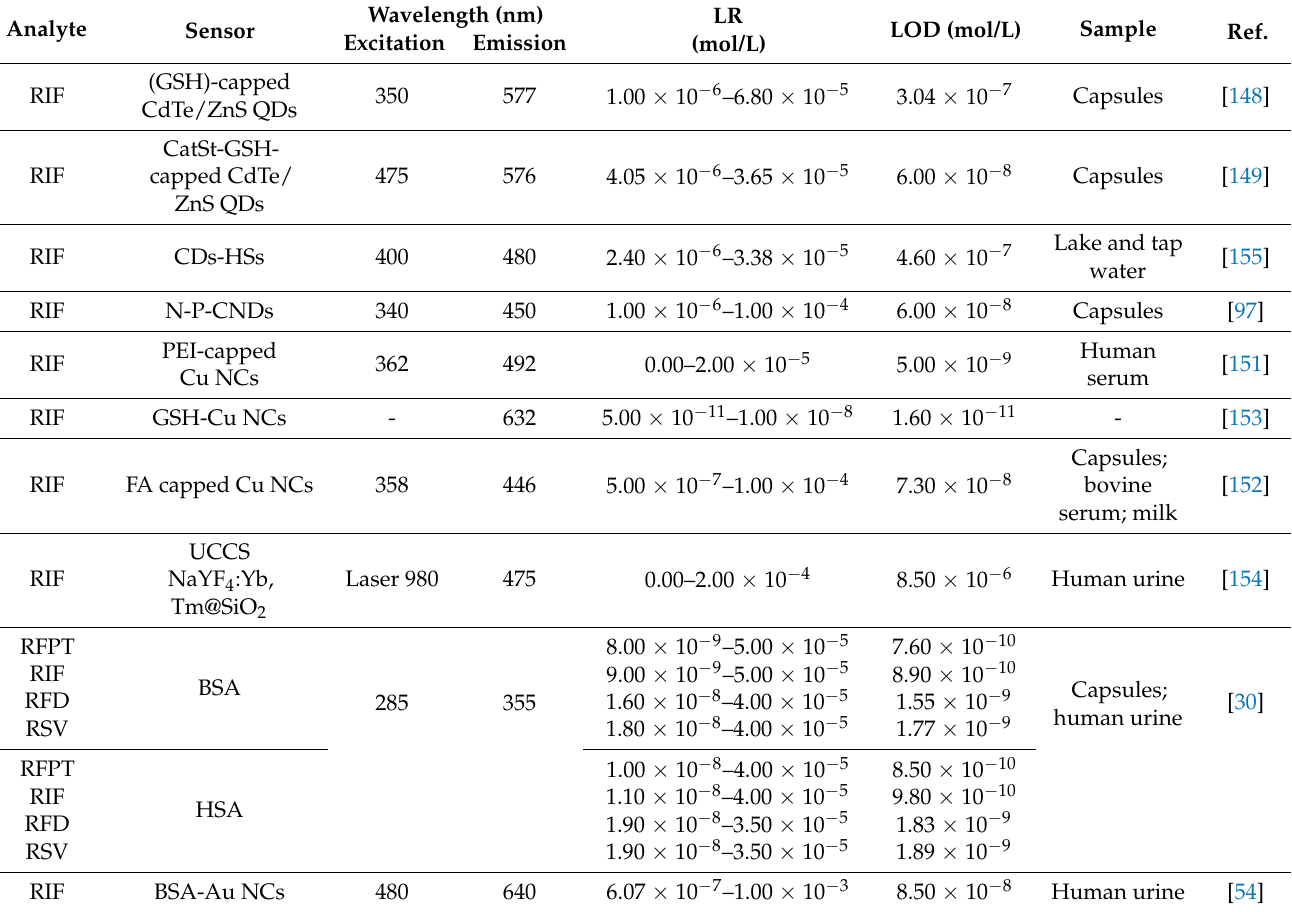
Figure 5. Schematic representation of RIF determination based on its fluorescence quenching ability. Table 3. The performance characteristics of the analytical methods based on fluorescence sensors reported in the literature for rifamycins determination.